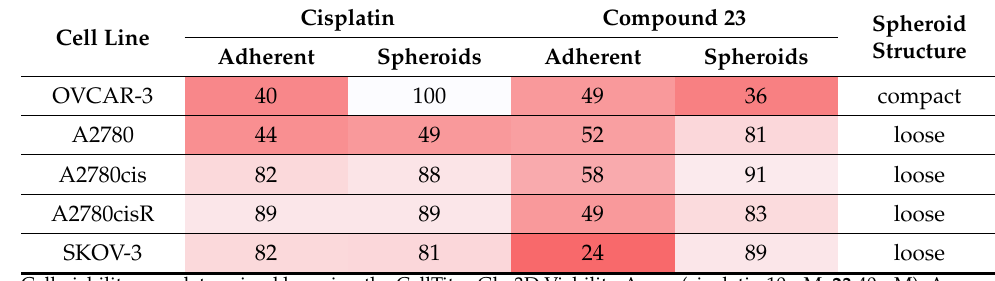
Cell viability was determined by using the CellTiter-Glo 3D Viability Assay (cisplatin 10 µ M, 23 40 µ M). Average percentage values of cell viability are shown (untreated cells, 100%). Color intensity corresponds to compound cytotoxicity. Color scale: from nontoxic (white) to the most toxic (red). OVCAR-3 cells grown in compact spheroids became refractory to cisplatin, but also became more sensitive to compound 23 . The cells in loose spheroids retained their sensitivity to cisplatin, but became resistant to compound